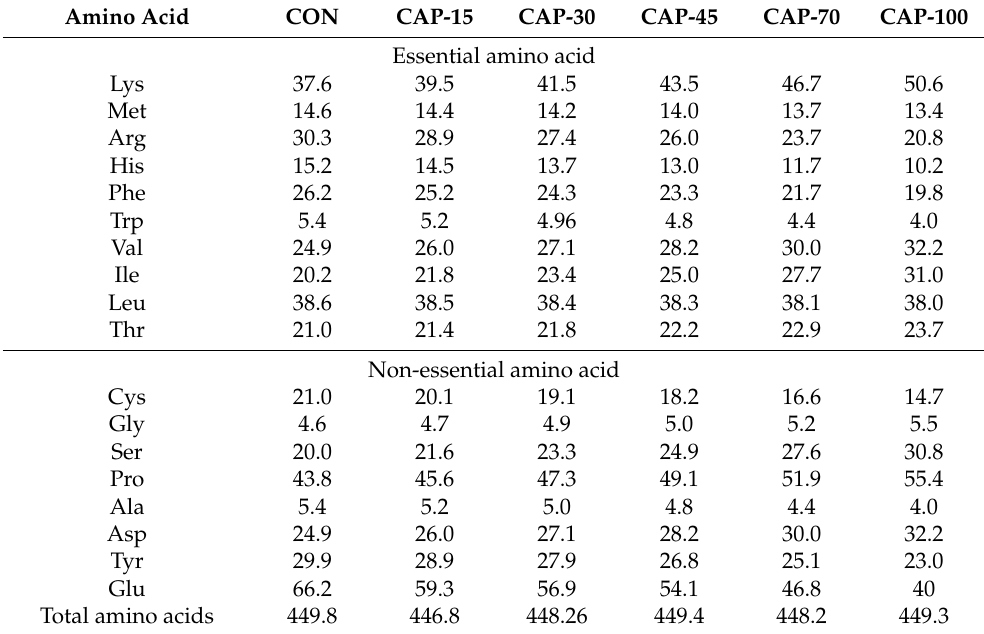
Table 2. Amino acid composition of experimental diets (dry matter basis,